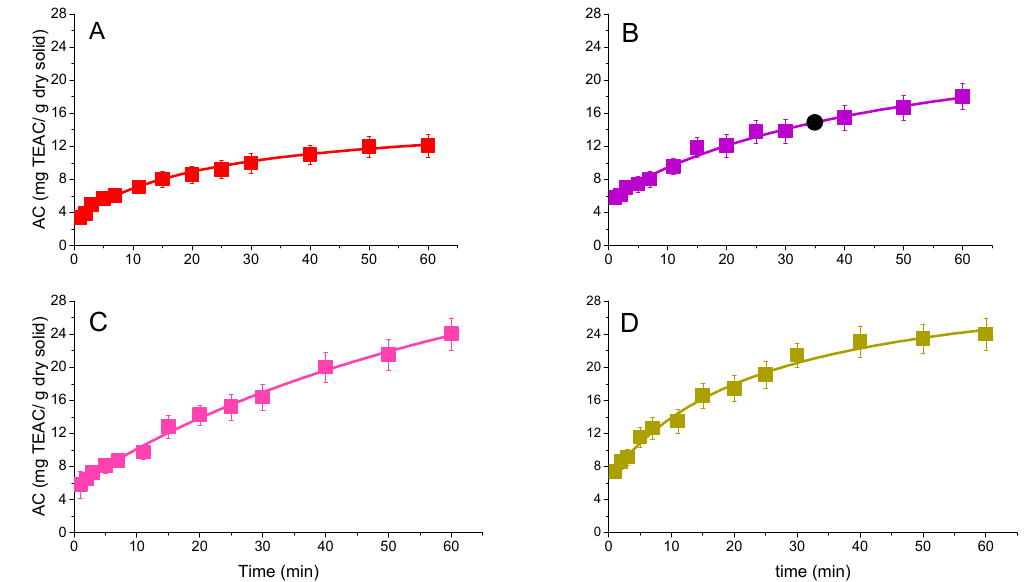
Figure 4. Kinetic analysis of the antioxidant activity as measured by the DPPH method during the extraction processes of AP employing a 70%/30% v/v ethanol/water mixture at several temperature values: ( A ) 25 °C, ( B ) 50 °C, ( C ) 70 °C, and ( D ) 90 °C. The lines show the fitting of a one-term second- order kinetic model (Equation (1)).